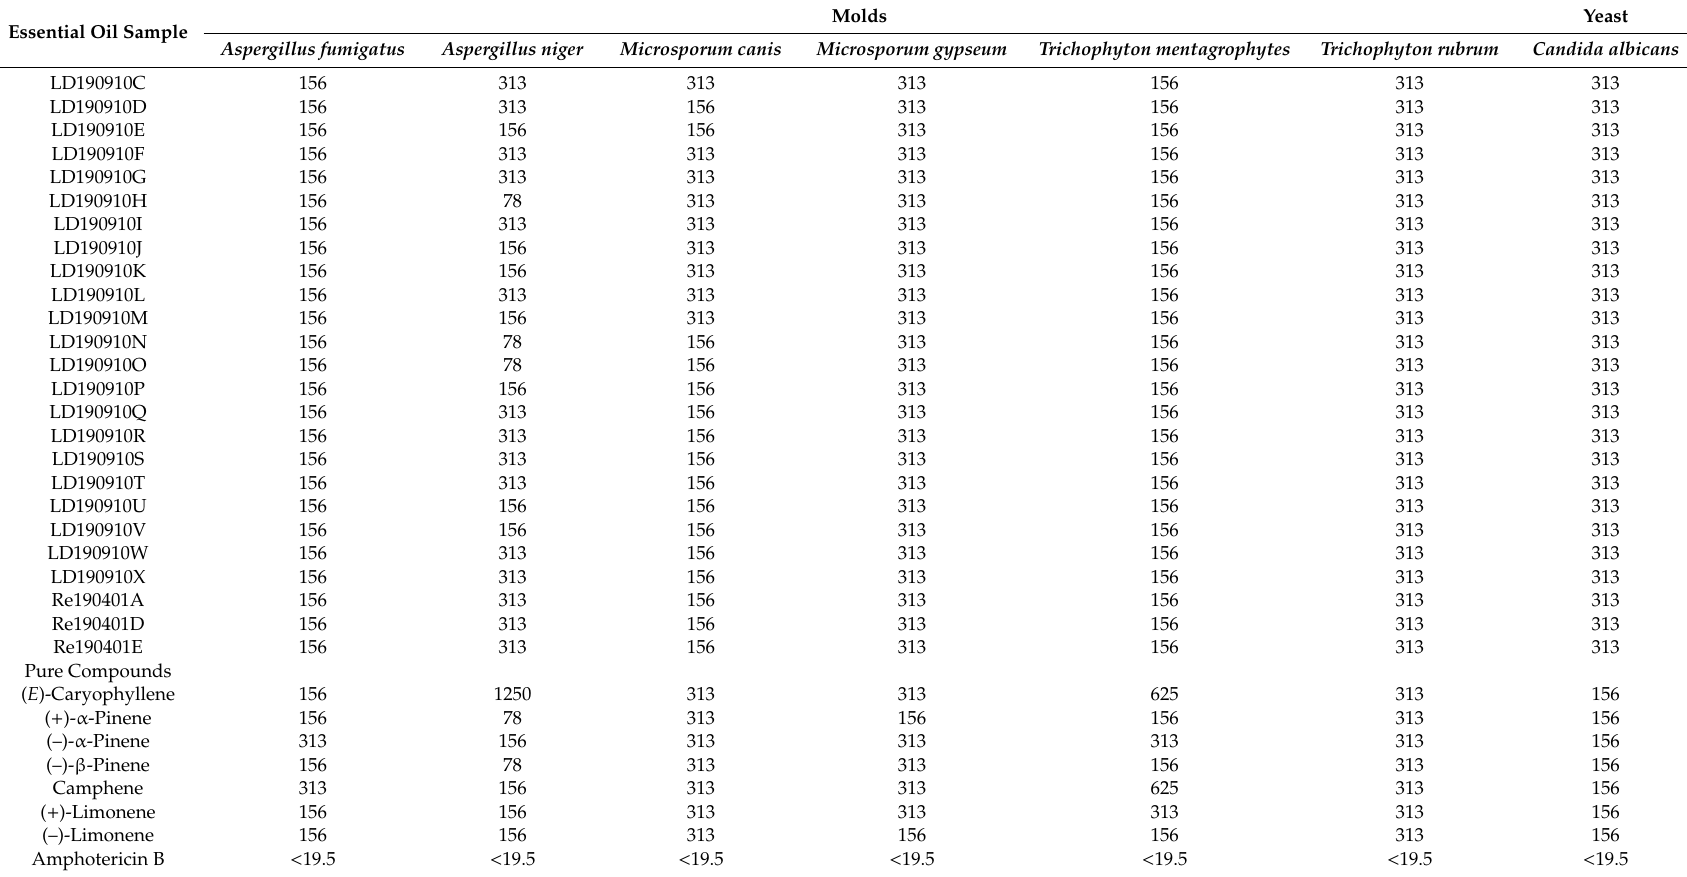
Table 4. Antifungal activities, MIC a ( µ g / mL), of oleoresin essential oils of Liquidambar formosana and major essential oil